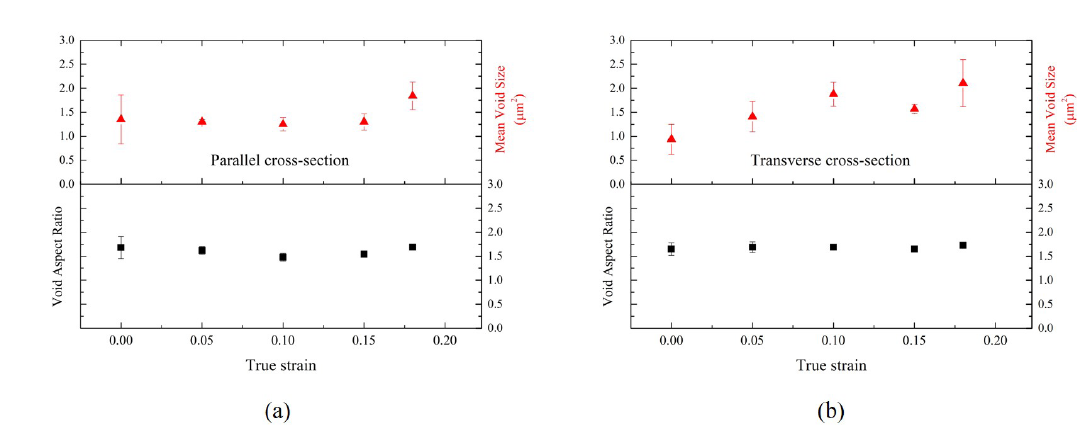
Figure 12. Void aspect ratio and mean void size results from the as-received condition and pre-straining levels in uniaxial tension: (a) parallel cross-section and (b) transverse